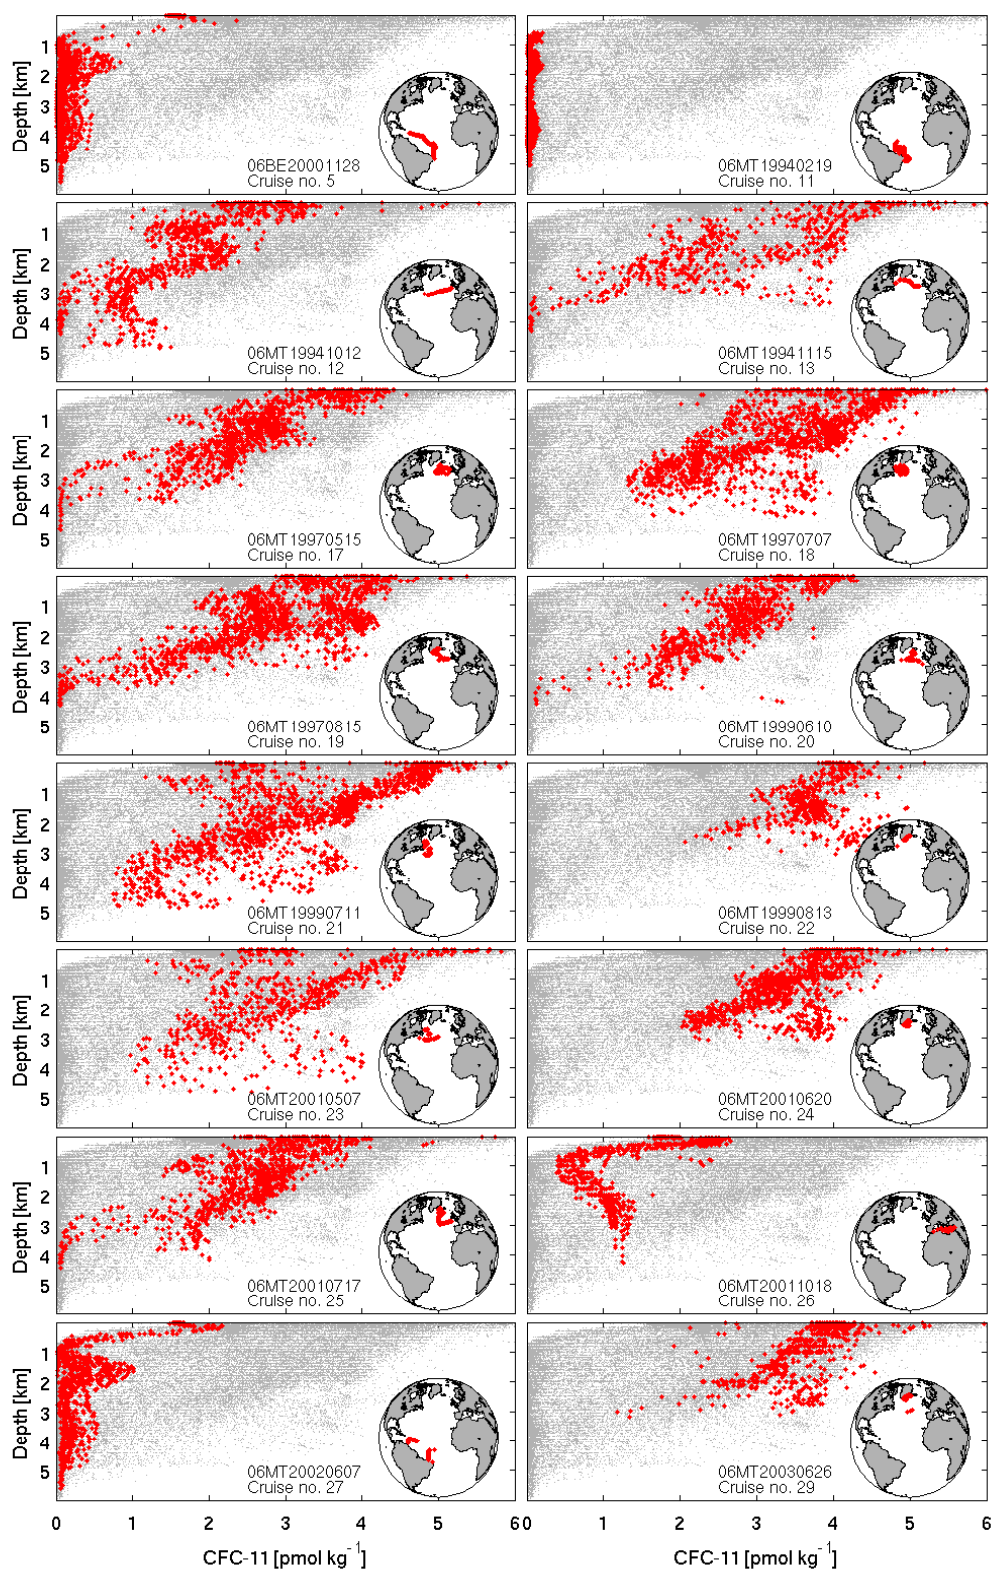
Figure 2. CFC-11 vs. depth for each cruise of the CARINA Atlantic data